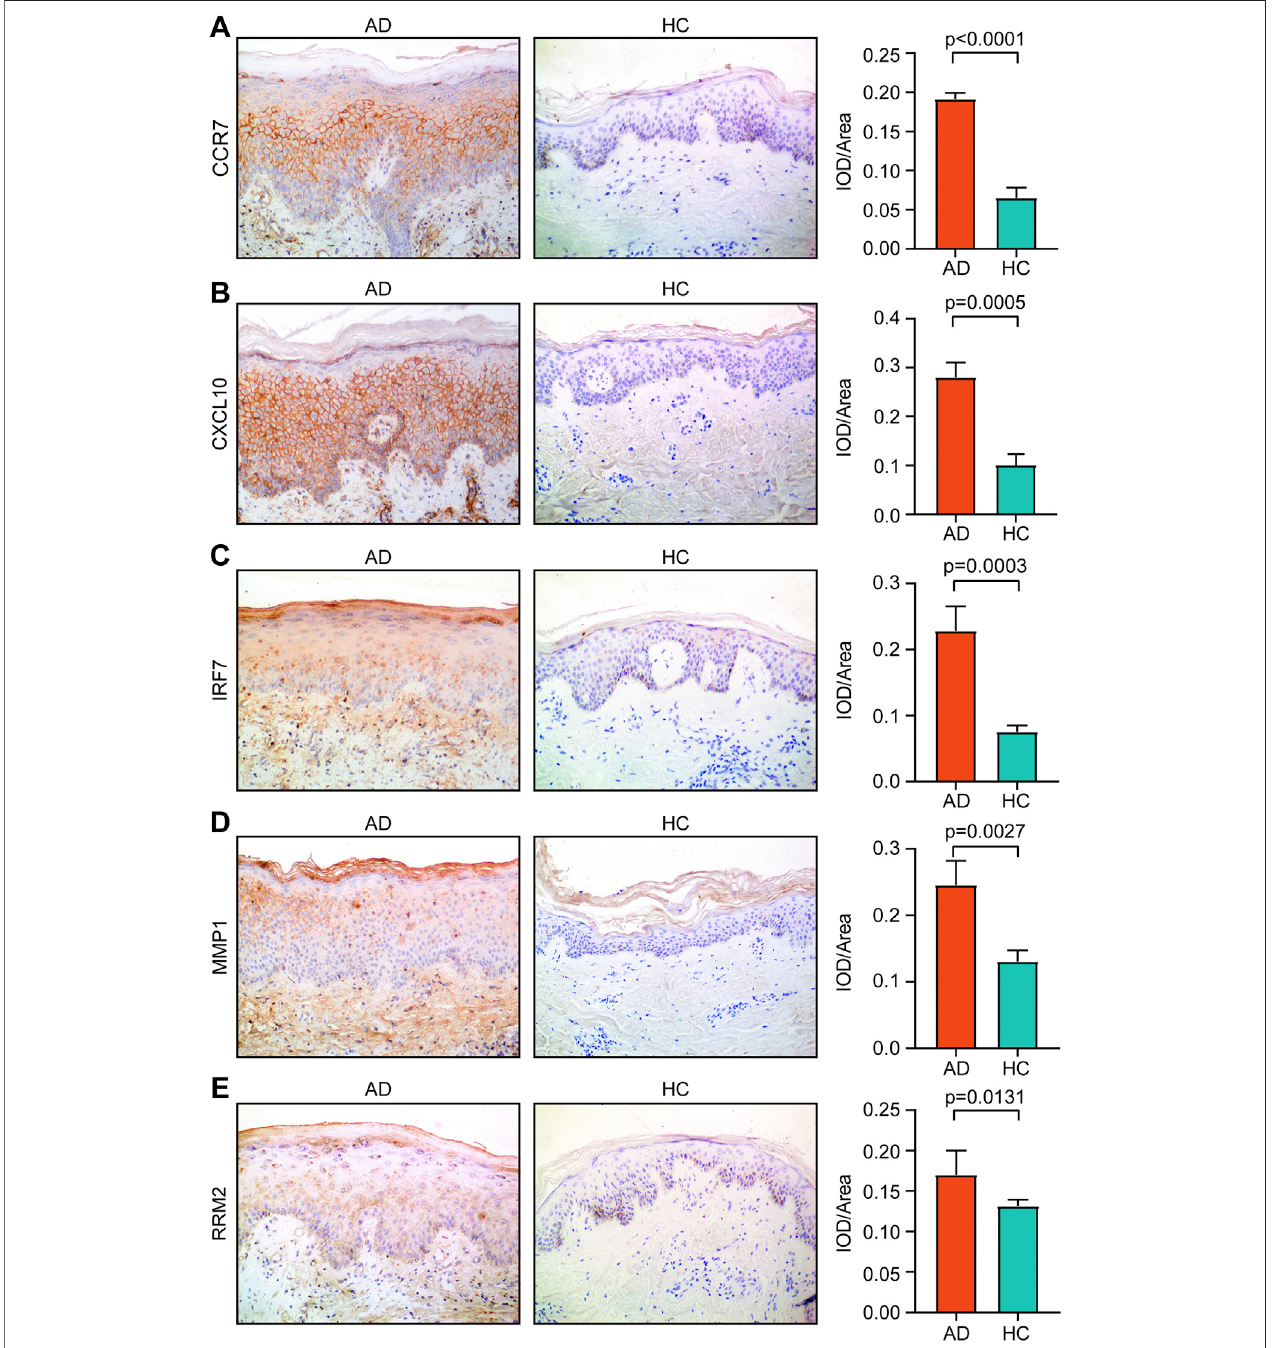
FIGURE 8 | Expression of (A) CCR7, (B) CXCL10, (C) IRF7, (D) MMP1, and (E) RRM2 in AD tissue and healthy tissue. Magni fi cation, ×200. AD, atopic dermatitis; HC, healthy control.